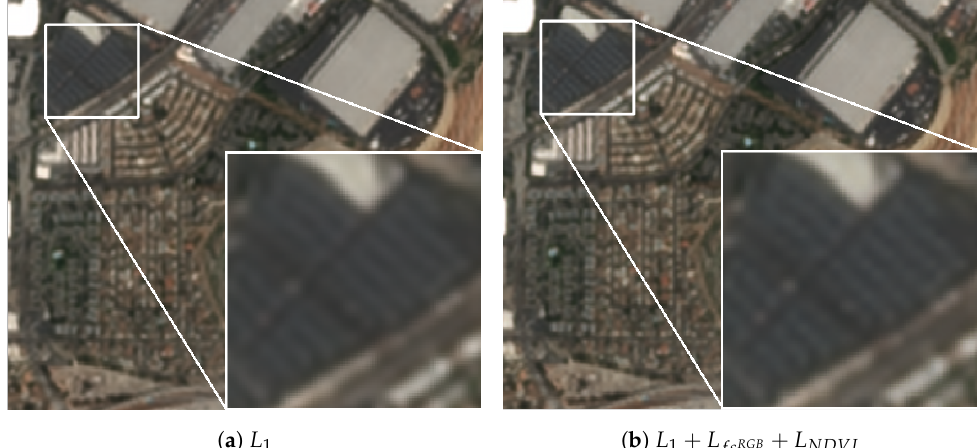
Figure 12. Comparison between the pixel loss ( L 1 ) and the L 1 + L fs RGB + L NDVI loss in a patch from La Habra